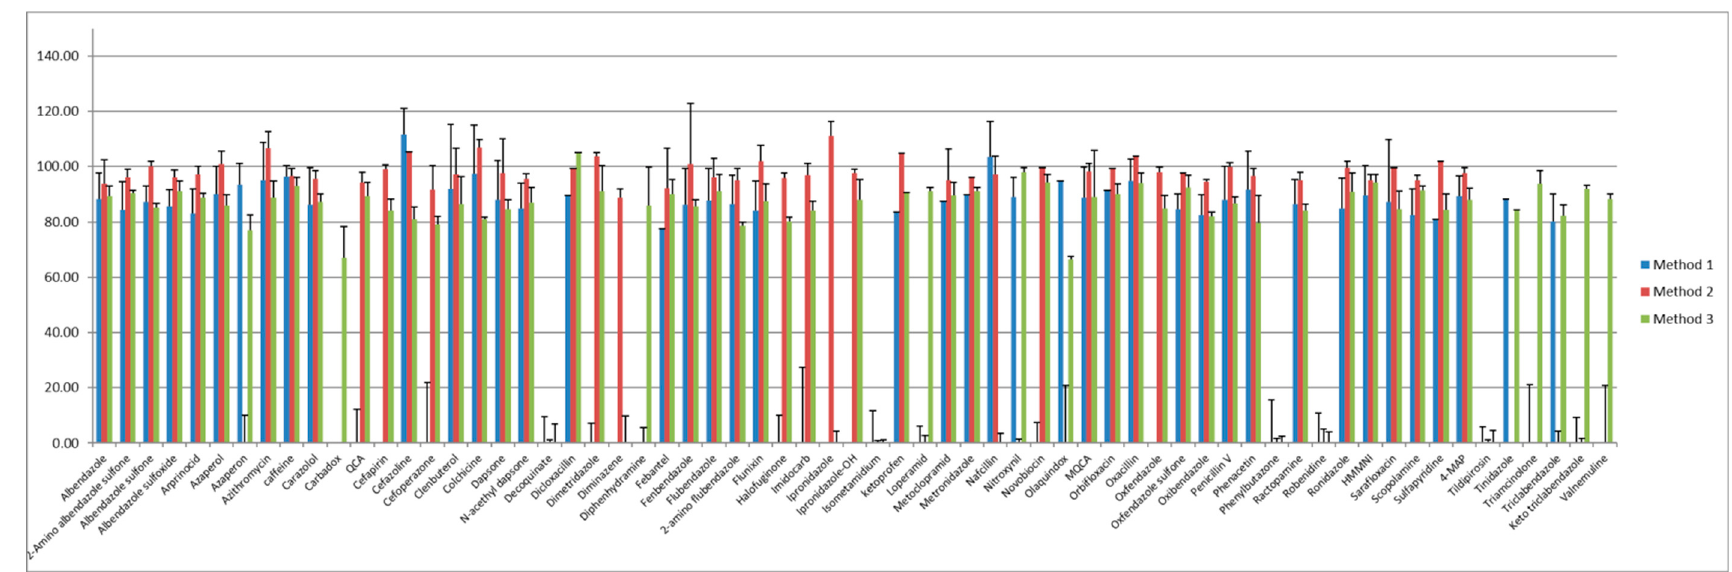
Figure 1. The comparison of targeted compounds for average recoveries (%) in flatfish in three multi-residue methods. Method 1: Ministry of Food and Drug Safety in Korea; Method 2: Food and Environment Research Agency in United Kingdom; Method 3: Food Safety and Inspection Service in United States.